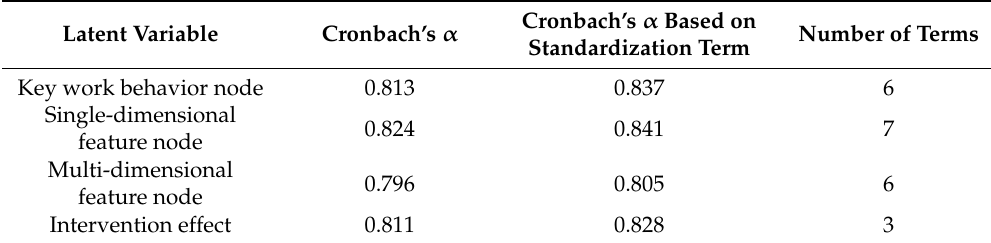
Table 4. Reliability test results for latent